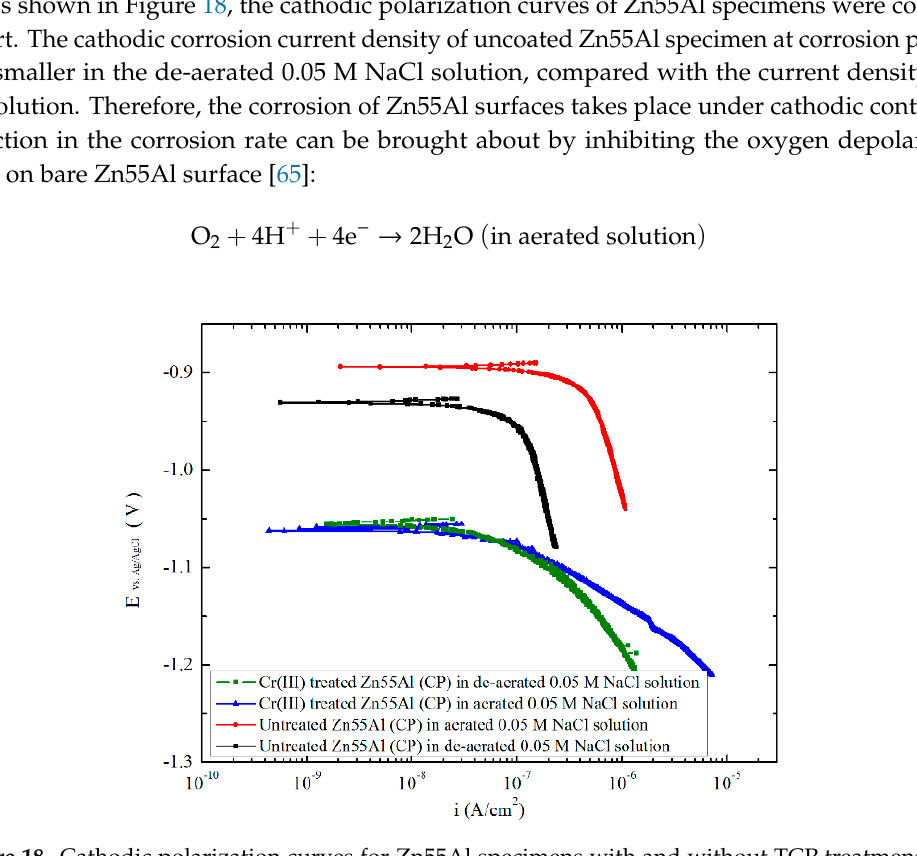
Figure 18. Cathodic polarization curves for Zn55Al specimens with and without TCP treatment in de-aerated or aerated 0.05 M NaCl solution. Table 2. Fitting results of cathodic polarization curves recorded in Figure 17. Specimens Curve E corr (V) i corr (A/cm 2 ) − 0.8936